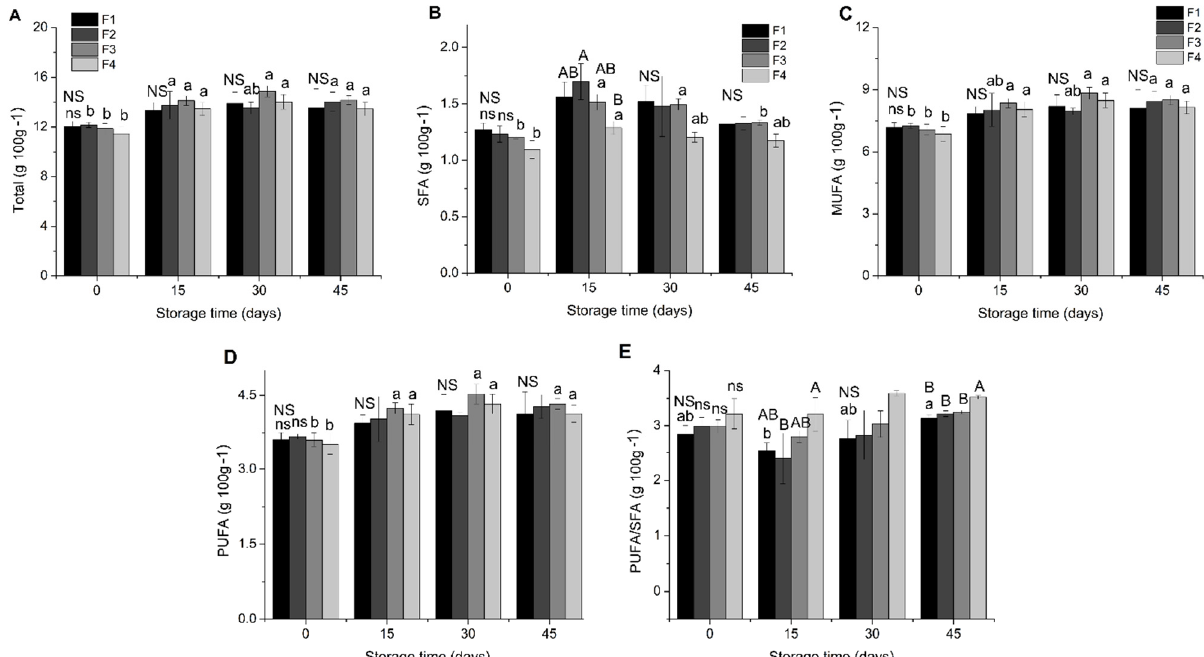
Figure 5. Fatty acids of starch biscuit formulation during storage. ( A ) Total FA: fatty acids; ( B ) SFA: saturated fatty acids; ( C ) MUFA: monounsaturated fatty acids; ( D ) PUFA: polyunsaturated fatty acids; ( E ) PUFA/SFA. F1: starch biscuit control (no added antioxidant); F2: starch biscuit added butylated hydroxytoluene (BHT); F3: starch biscuit added microencapsulated propolis co-product (MECP); F4: starch biscuit added lyophilized propolis co-product (LFCP). NS: there is no statistical difference ( p > 0.05) by the Tukey test between the formulations in the respective storage time. Different capital letters above a column represent statistical difference ( p < 0.05) by the Tukey test between the formulations in the respective storage time. Different lower-case letters above the column represent statistical difference ( p < 0.05) by the Tukey test for the different storage time.